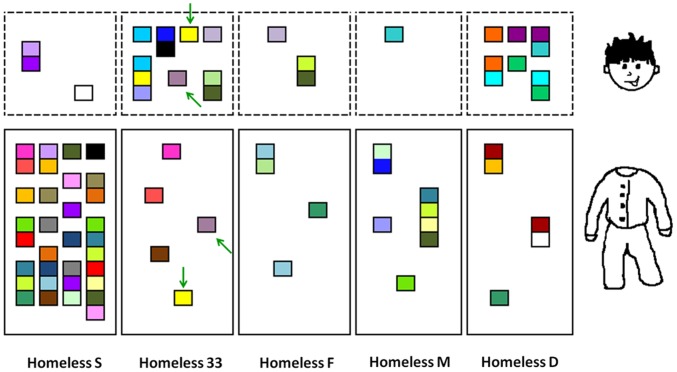
Repartition of head and body lice haplotypes found at least twice in our samples.The haplotypes are concatenated alleles of the S2, S5 and PM2 spacers. A single color was assigned to each unique haplotype. Each block represents one louse, but may be separated into several colored units if the alleles at the three spacers could be combined to generate multiple haplotype possibilities. The green arrows indicate identical head and body lice haplotypes collected from the same homeless person.